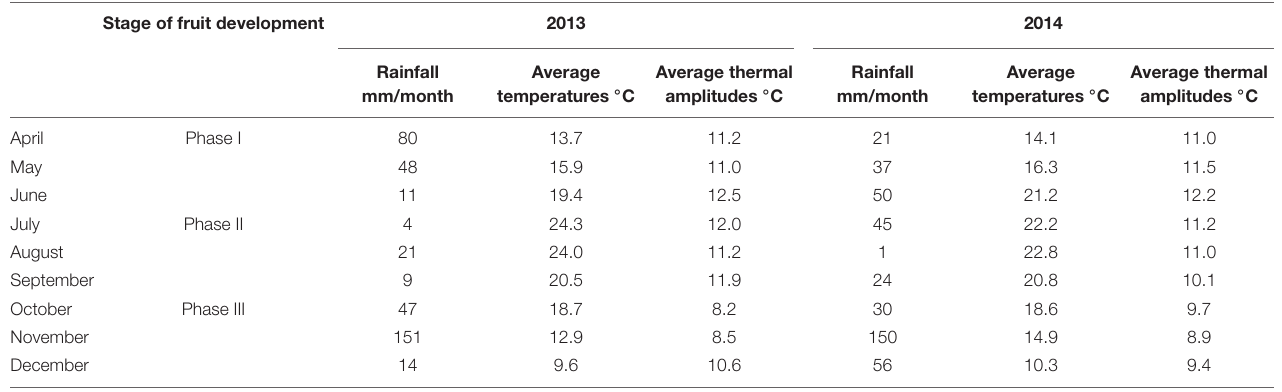
TABLE 1 | Climatic characteristics during the study (2013 and 2014) according fruit development stages (Phase I, II, and II). Stage of fruit